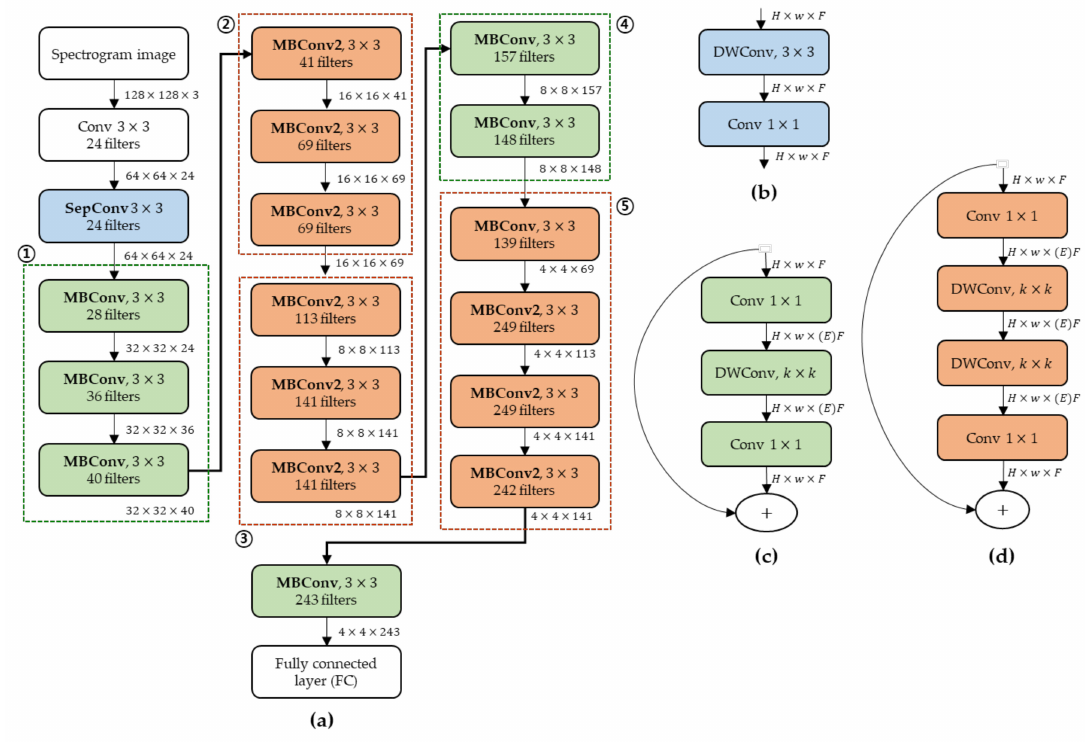
Figure 7. MnasNet architecture after applying the 8-bit clustering method: ( a ) MnasNet: 8-bit filters clustering algorithm applied to all layers; ( b ) SepConv; ( c ) MBConv(E), k × k ; and ( d ) MBConv2(E), k × k .